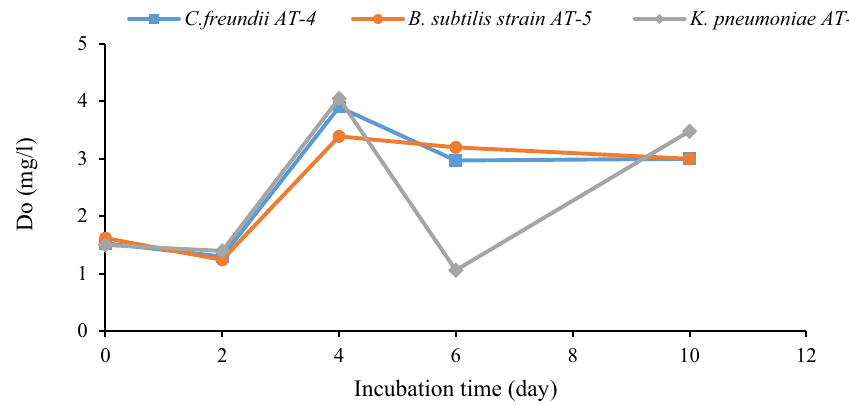
Figure 5. DO variations during RPCM effluent degradation (effluent + culture + mineral salt + glucose).